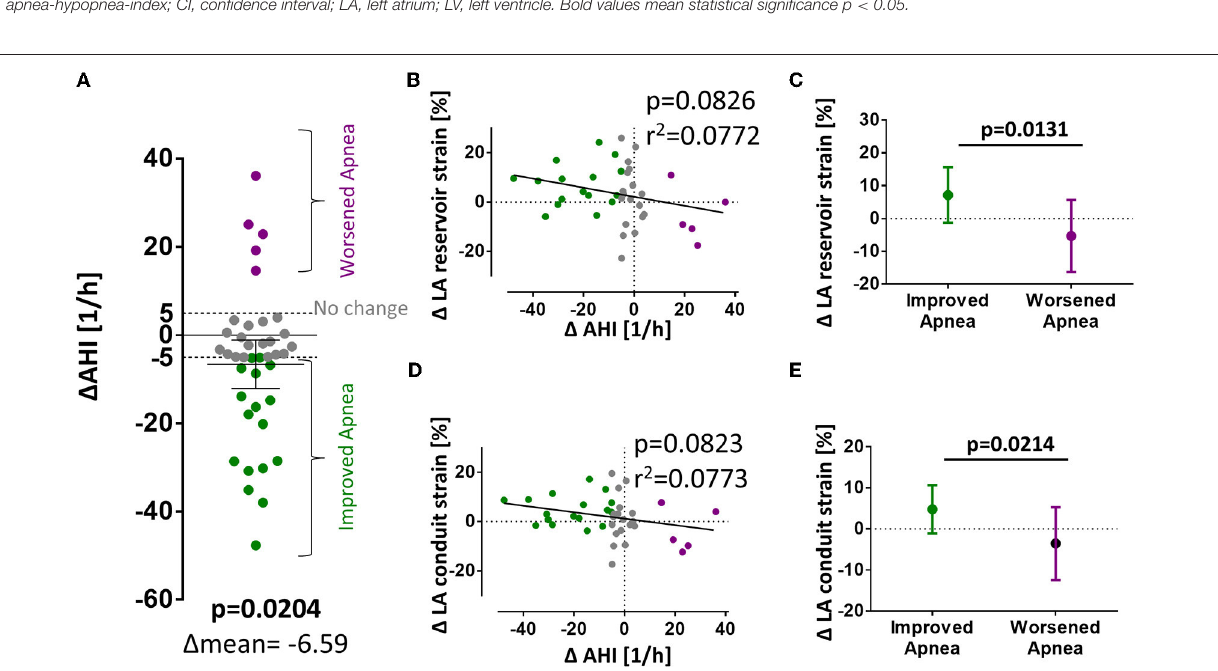
Frontiers in Medicine |